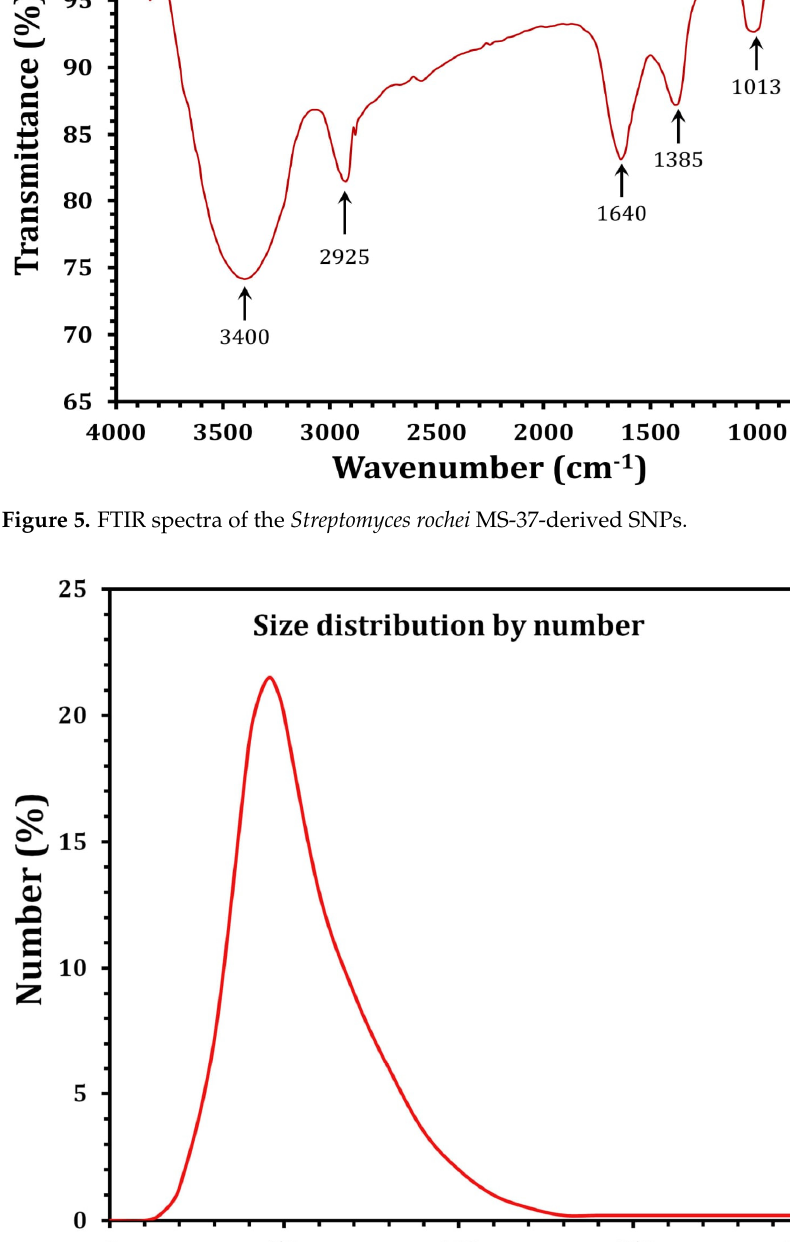
Figure 7. Zeta potential result of the Streptomyces rochei MS- 37 SNPs. In most cases, bacteria that prevent the formation of periodontal pockets are the cause of periodontal infections [5]. Microbes thrive in periodontal pockets because they provide an ideal environment for them to survive and grow [72]. Dental cleanliness, pocket depth, the flow of gingival crevice fluid, gingivitis severity, type of interacting bacteria and vi- ruses, host immune response, emerging pathogens, and antibiotic resistance all have an impact on the quantity and variety of microorganisms in the mouth [73]. As a result of their low cost and high effectiveness, antibiotics have traditionally been used to treat bac- terial infection [55]. Several studies have found that widespread antibiotic use has resulted